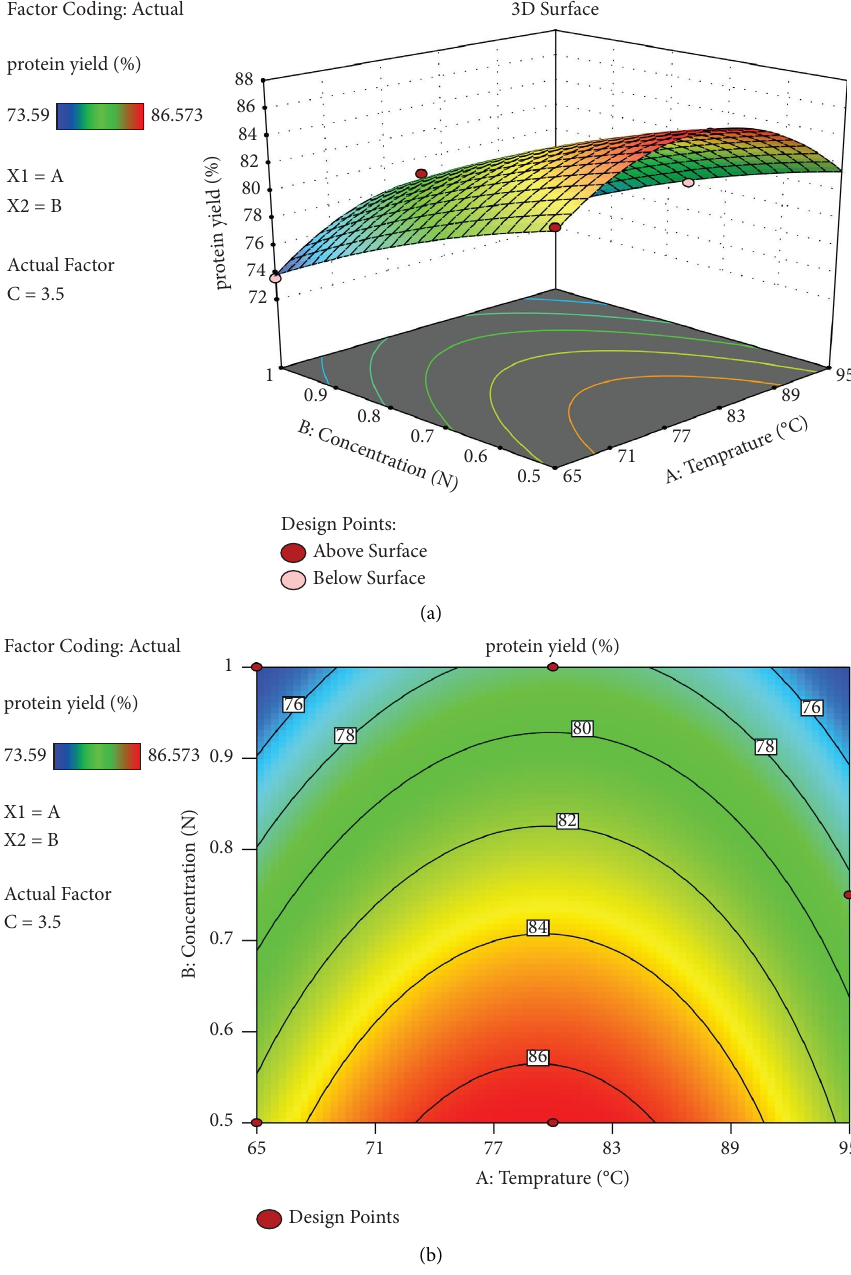
Figure 10: (a) 3D interaction efect of temperature and concentration (b) contour plot interaction efect temperature and